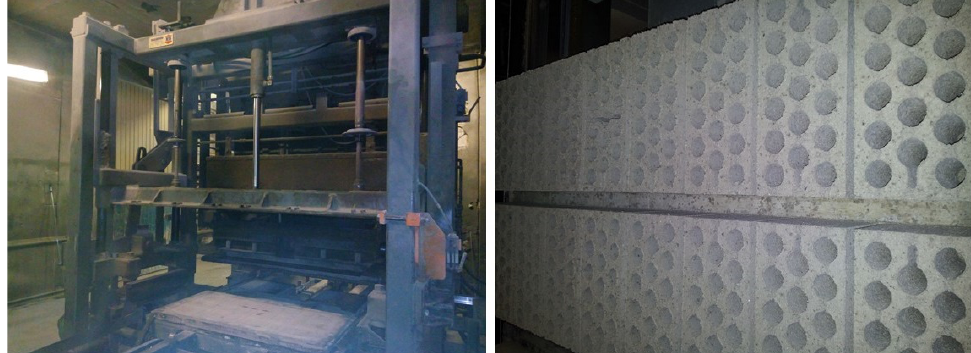
Figure 2. Brick manufacturing: compacting unit ( left ); and tray conveyor ( right ).